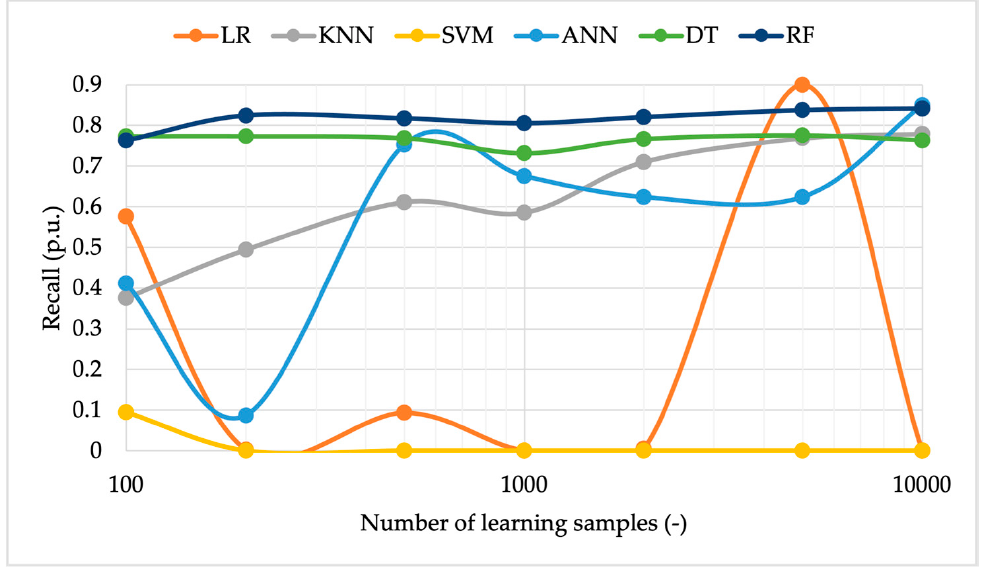
Figure 12. Algorithm recall vs. the number of learning samples using normal distributed inputs.